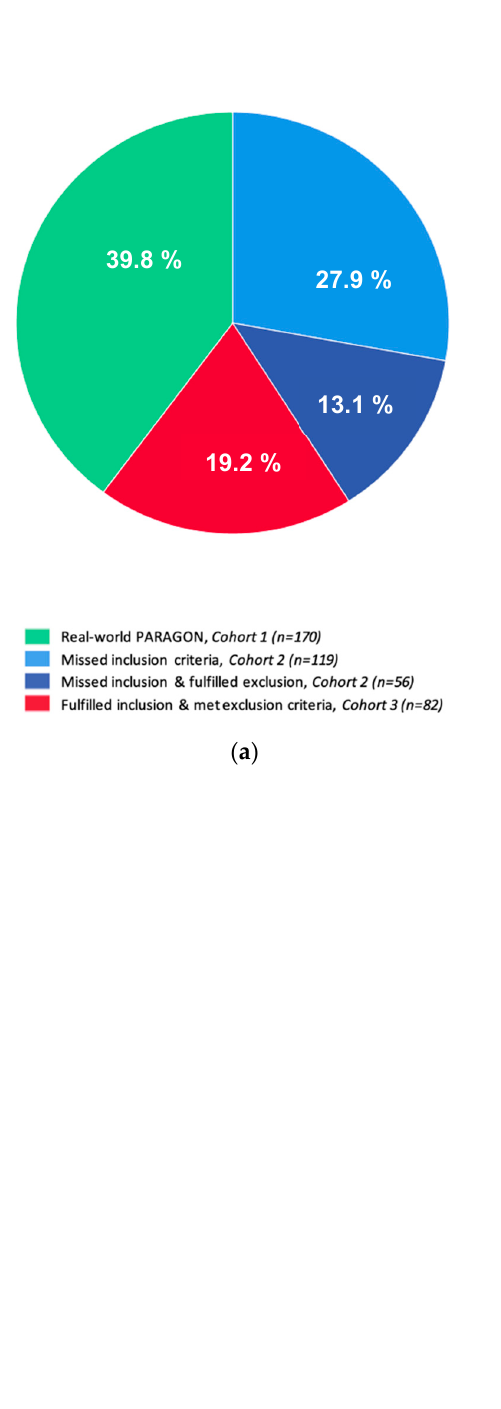
Figure 2. Main reasons for missing inclusion or fulfilling exclusion criteria of PARAGON-HF. ( a ) Represents a graphical description of our real-world HFpEF cohort according to PARAGON-HF eligibility. ( b ) Shows a detailed listing of reasons for missing inclusion and / or fulfilling exclusion criteria of PARAGON-HF. Values are given as total numbers and percent. NT-proBNP indicates N-terminal prohormone of brain natriuretic peptide; HF, heart failure; NYHA, New York Heart Association; BMI, body mass index; eGFR, estimated glomerular filtration rate; COPD, chronic obstructive pulmonary disease.